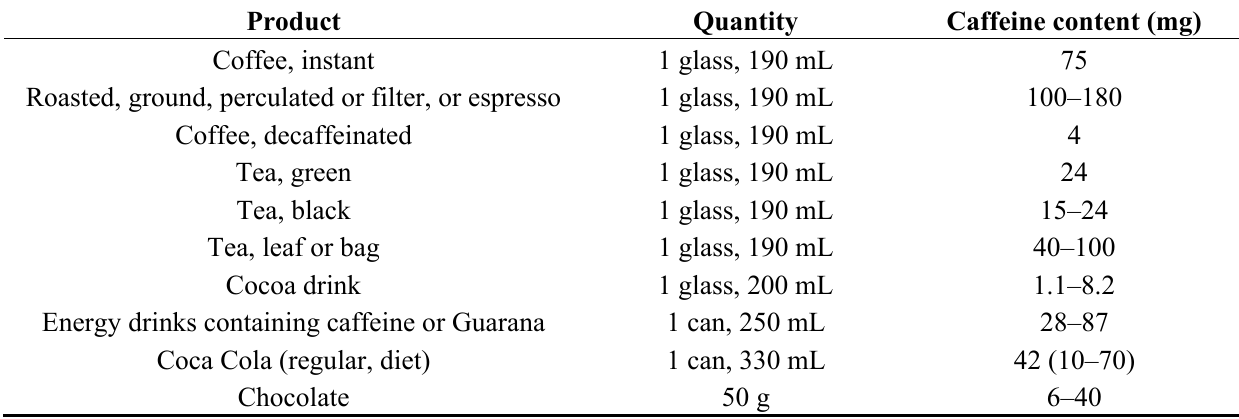
Table 6. Caffeine content in selected food and drink